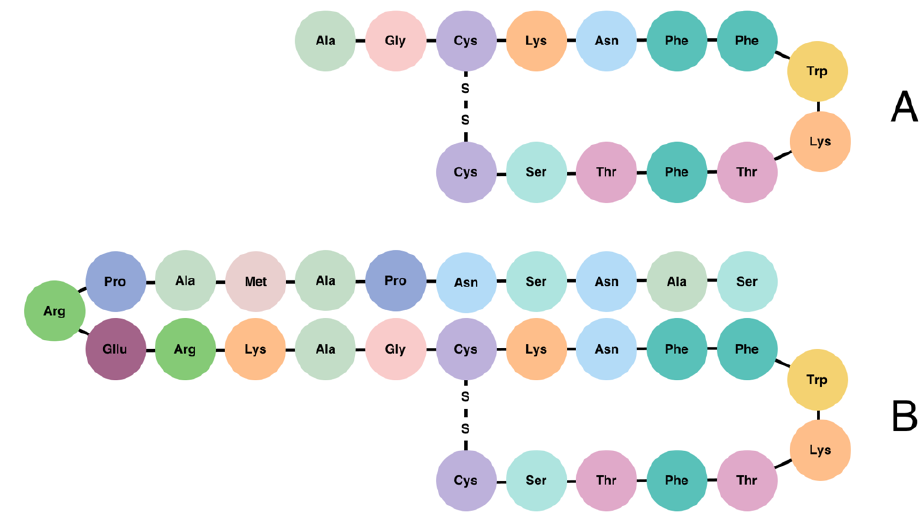
Figure 1. Structure of somatostatin-14 ( A ) and somatostatin-28 ( B ). The activity of SST is mediated by its binding to five subtypes of SSTRs, each encoded by five different genes segregated on chromosomes 14, 17, 22, 20, and 16, respectively [17]. The SST receptor subtypes (SSTR1 through SSTR5) share signalling pathways and structural features [18]. Two isoforms of SSTR2 exist (SSTR2A and SSTR2B), and are produced via alternative splicing [19,20]. These variants of SSTR2 differ in the length of their C- terminal cytoplasmic tails as well as their ability to couple to adenylyl cyclase; as a result, SSTR2A and SSTR2B may activate alternative signal transduction pathways [21,22]. SSTRs